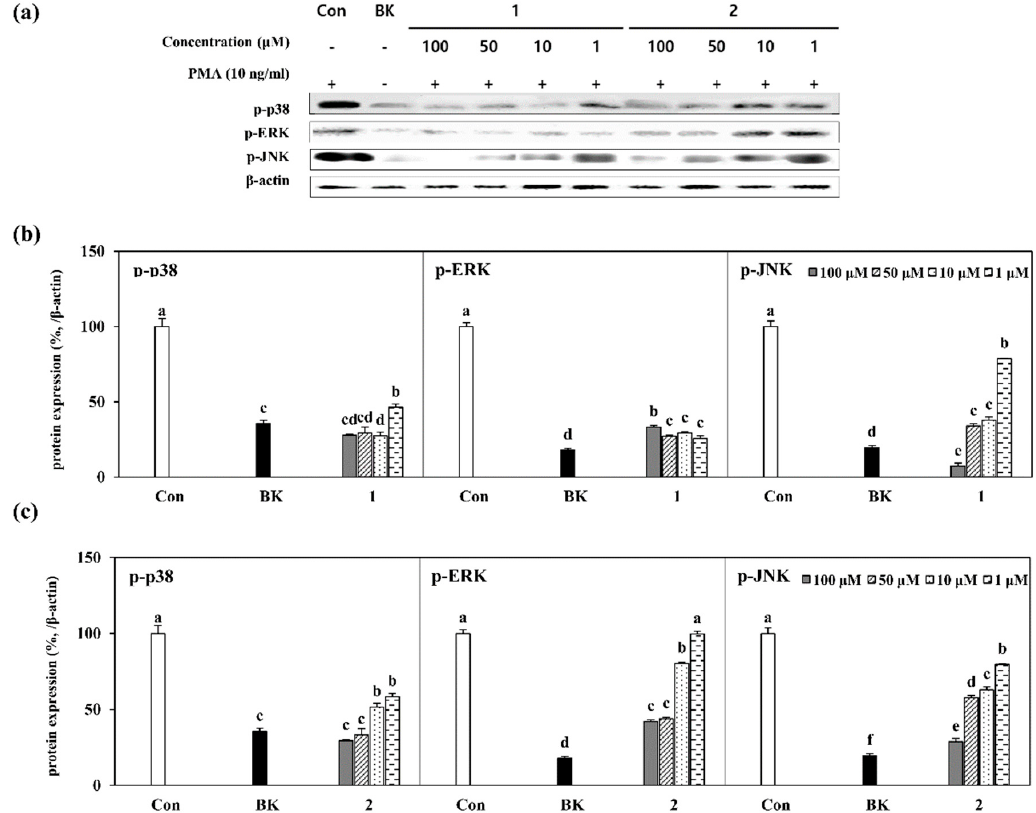
Figure 5. Effect of GL-3 ( 1 ) and oleonuezhenide ( 2 ) on the levels of phosphorylated (p-) p38, ERK and JNK proteins of MAPK pathway. ( a ) Cells were treated with indicated concentrations of compounds 1 and 2 prior to stimulation with PMA for 1 h and further incubated for 24 h. The levels of proteins were detected using Western blotting and given as images of protein-specific bands. β -Actin was used as an internal standard. ( b , c ) Relative expression levels of p-p38, p-ERK and p-JNK proteins were given as percentage of stimulated untreated control cells (Con) after normalizing against internal control. Quantification of the bands was achieved by densiometric calculations. Values are mean ± SD of three independent experiments. a–f Means with different letters are significantly different at p < 0.05 level. (BK: untreated unstimulated cells).